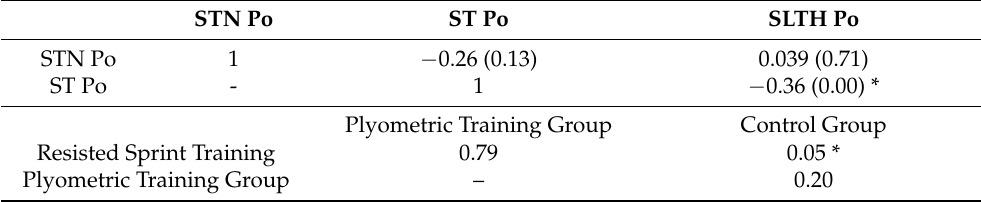
Table 5. Correlation of strength, sprint test, and single leg triple hop test at